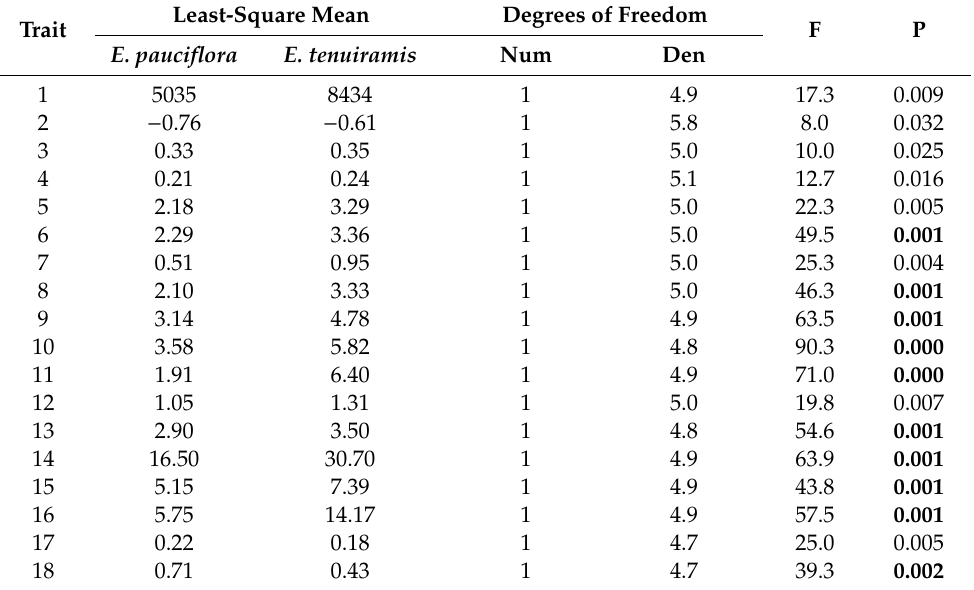
Figure 4. Relationship between field-measured and LiDAR-derived tree height ( a ), crown width ( b ), stem DBH ( c ) and crown insertion height ( d ). Points correspond to the 557 trees sampled in the field, with the line of best fit (red line) and 95% confidence intervals (dashed black lines) shown. Within each plot, the slope ( β ), F statistic with its numerator and denominator degrees of freedom and corresponding p-value and the coefficient of determination (R 2 ) are shown. Table 2. Statistical results from the species-level linear mixed-effect model for 25 traits derived from individual tree LiDAR point clouds. Shown is the estimated numerator (Num) and denominator (Den) degrees of freedom based on the Kenward–Roger approximation, the F statistic, and its probability for the fixed-effect difference between E. pauciflora and E. tenuiramis . Also shown are the least-square means for each trait estimated from the fitted mixed-effects model. Values in bold correspond to traits significant after a Bonferroni adjustment. Least-Square Mean Degrees of Freedom Trait F P Trait E. pauciflora E. tenuiramis Num